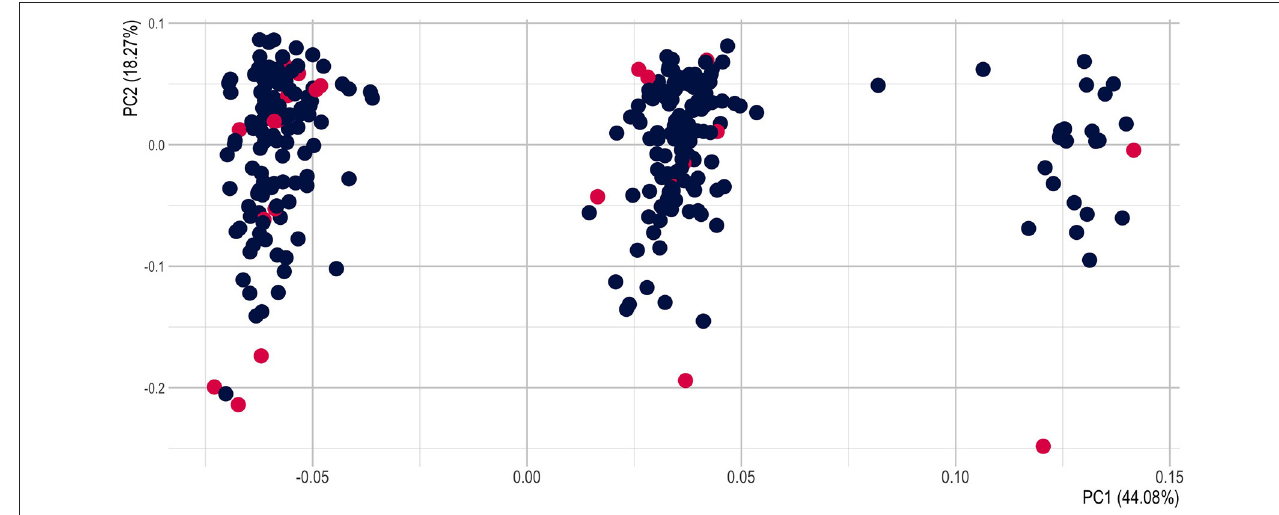
FIGURE 5 | PCA of Panax vietnamensis populations showing wild (red) vs. cultivated (blue)